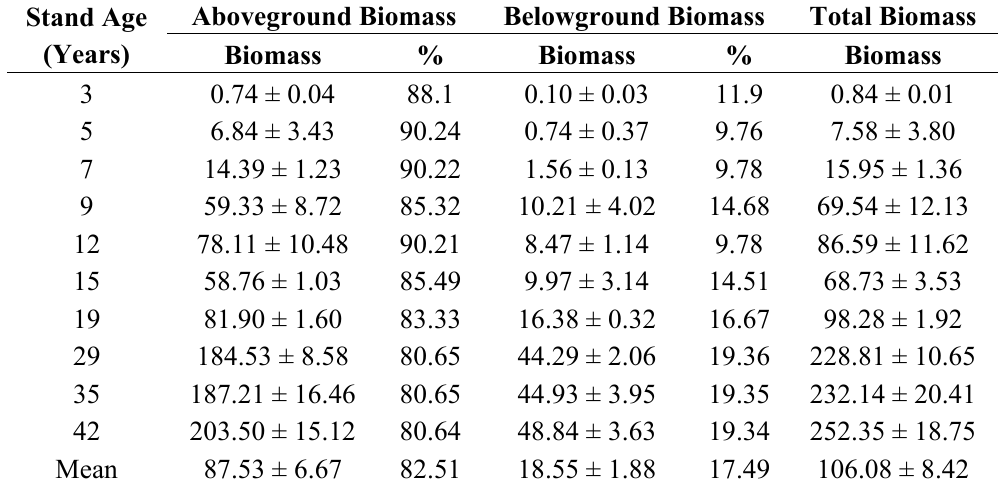
Table 2. Biomass (t·ha −1 ) and its allocation in the tree layer of the different stand ages of Pinus massoniana plantations in Gao County, Sichuan Province. Aboveground Biomass Belowground Biomass Total Biomass Stand Age (Years) % Biomass